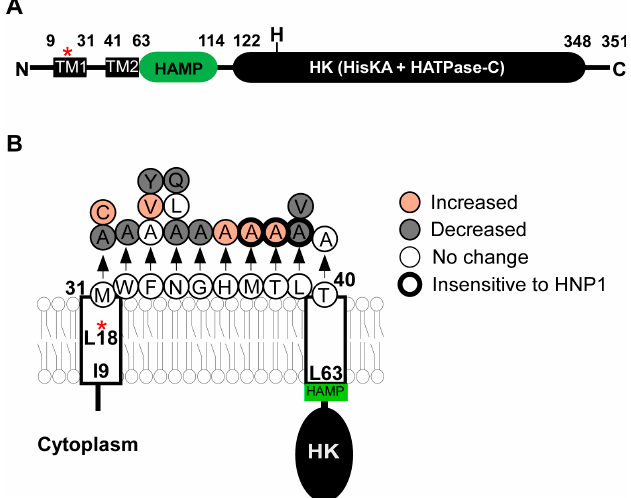
Figure 2. The SaeS protein. ( A ) The domain structure of SaeS. The numbers represent the boundary amino acids. The red star indicates the L18P mutation of SaeS in the strain Newman. N,N-terminus; H, His 131; C,C-terminus; TM, transmembrane helix; HK, histidine kinase; ( B ) A summary of mutations in the transmembrane domain of SaeS. Increased, Increased basal kinase activity; Decreased, Decreased basal kinase activity; No change, No effect on the basal kinase activity; Insensitive to HNP1, Kinase activity does not respond to HNP1. The positions of amino acids are all predictions.